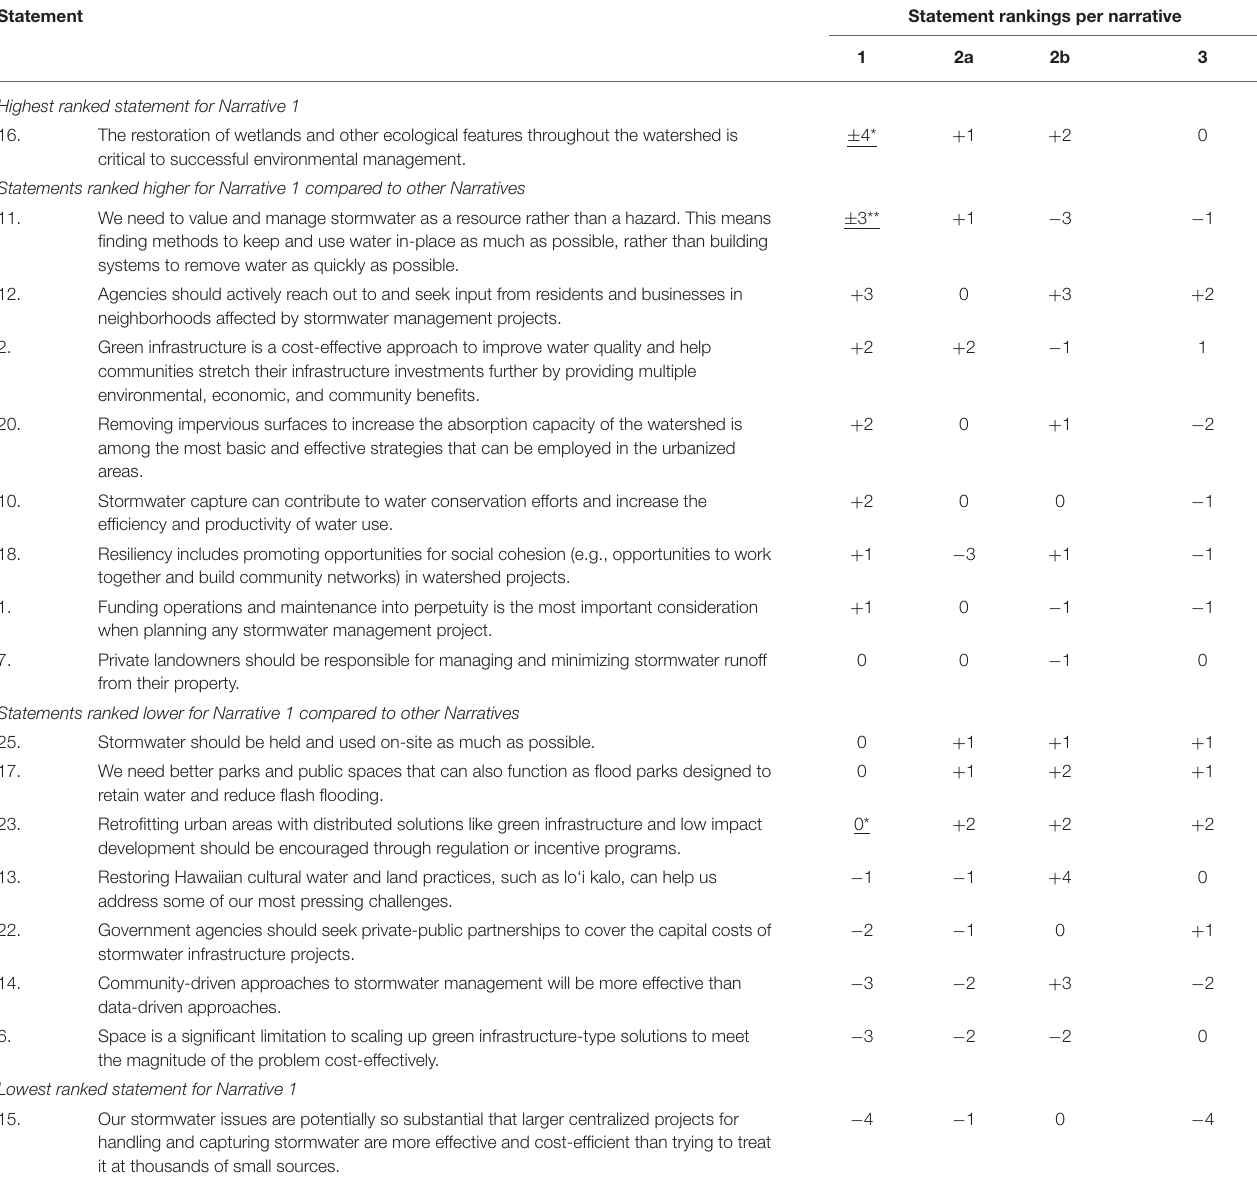
TABLE 4 | Summary of notable statements for Narrative 1 (PC